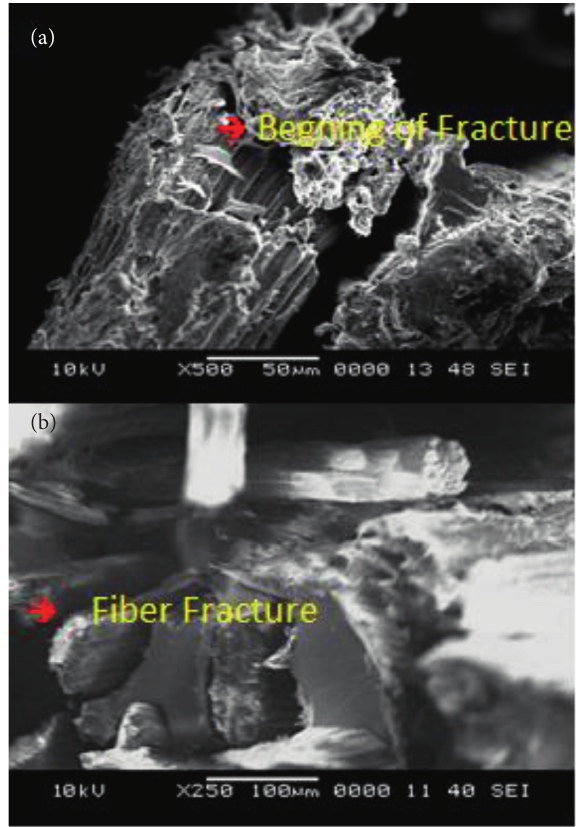
Figure 11: Impact test: (a) NaOH-treated fiber with polyester; (b) CaCO